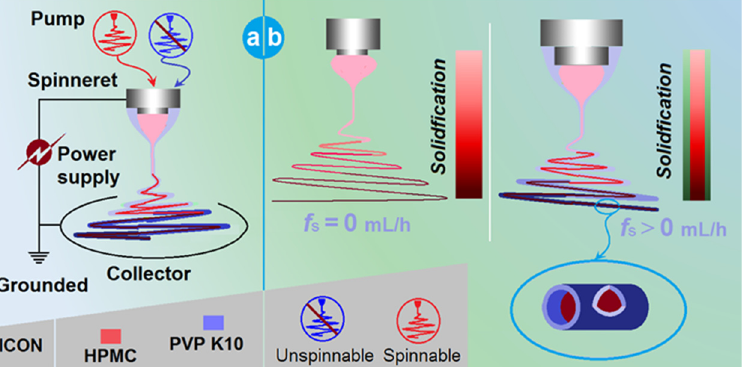
Figure 1. A diagram showing the coaxial apparatus that was explored for both a single-fluid blending process and a modified, coaxial process: ( a ) the parts of the electrospinning apparatus; ( b ) the two processes with different sheath fluid flow rates ( f s ).